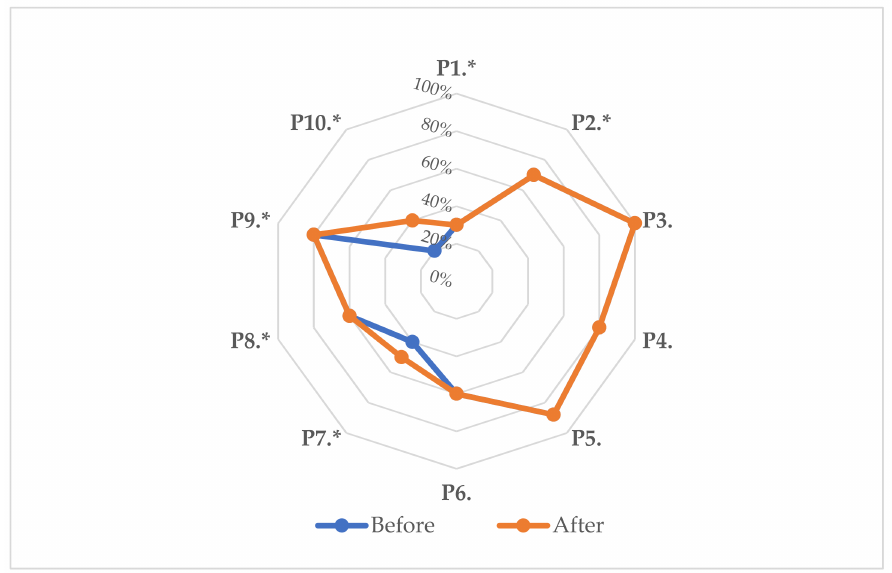
Figure 7. Radar graph with the lean maturity grades/scores for the present case study. Before data are taken from Table 4 (blue); After data resulted from the application of the solutions in Section 3.2.6 (orange). (*) denotes a principle whose mathematical definition is